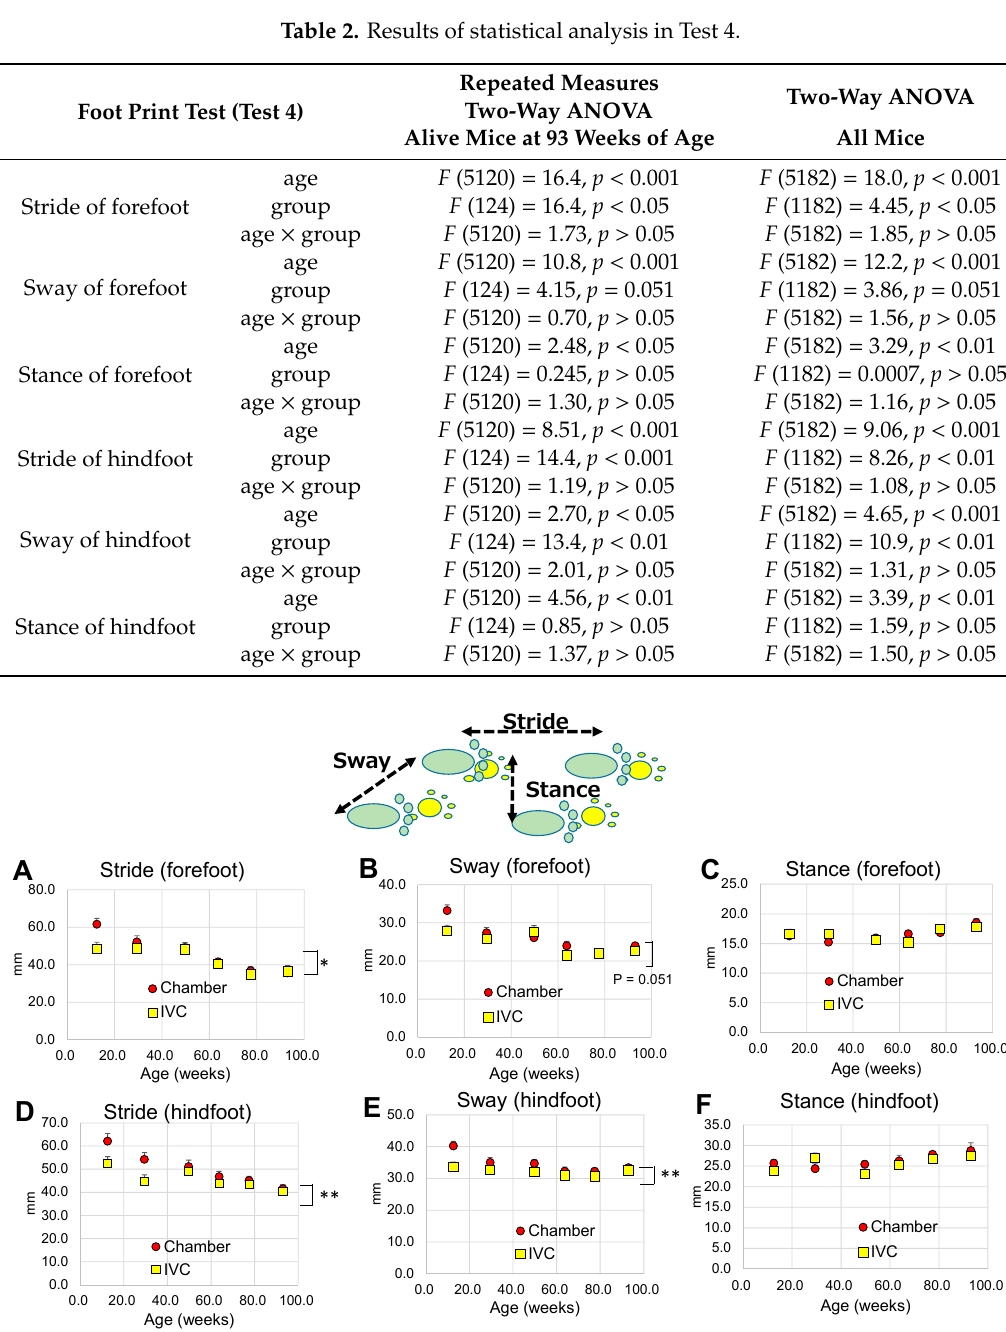
Figure 6. Changes in footprint with aging in the chamber and IVC groups (Test 4): Forefoot; ( A ) stride, ( B ) sway, ( C ) stance, Hindfoot; ( D ) stride, ( E ) sway, ( F ) stance. ** p < 0.01; * p < 0.05 by two-way ANOVA.